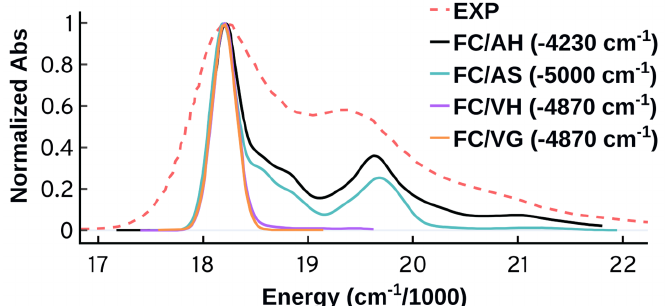
Figure 7. Spectra at 0 K obtained using the Franck–Condon adiabatic (AH and AS) and vertical (VH and VG) approaches. The time-independent (TI) approach at 0 K was used. The spectra are normalized and shifted to match the maximum of the experimental